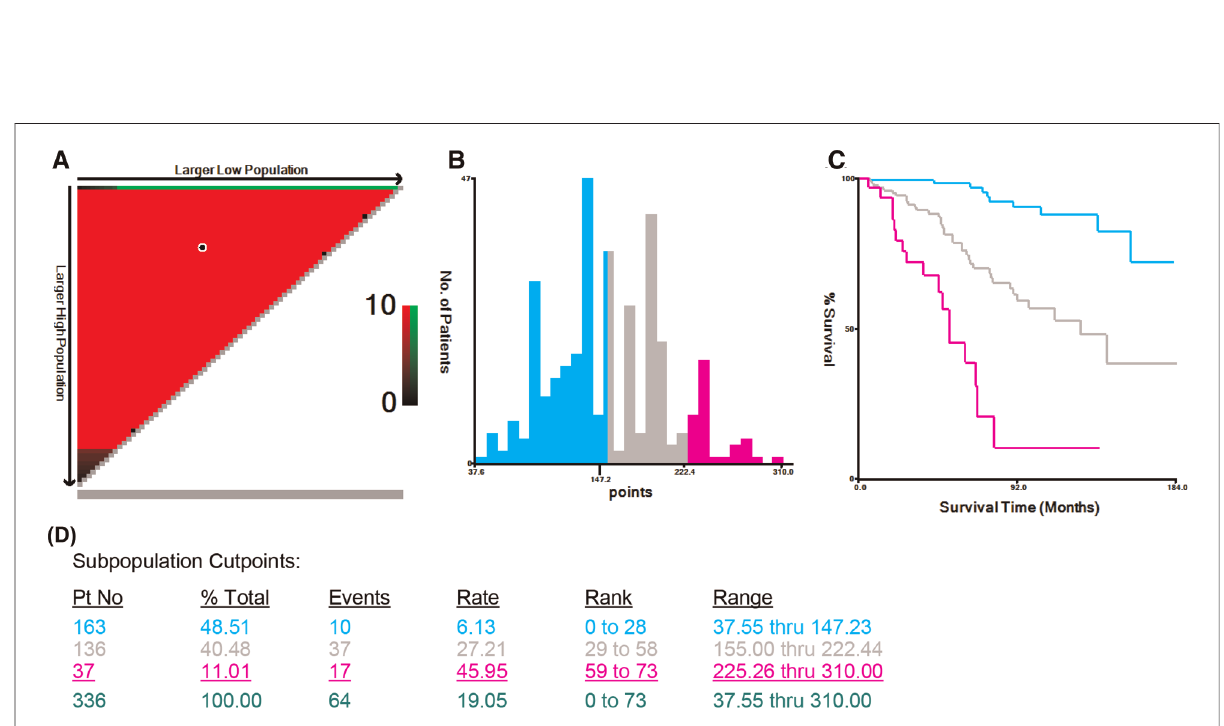
FIGURE 6 X-tile analysis of survival data from the Surveillance, Epidemiology, and End Results registry, including the X-tile plot ( A ), a histogram ( B ), the Kaplan- Meier curve ( C ), and the data ( D ) related to optimal